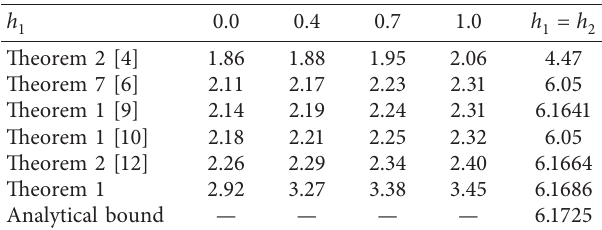
for different h 2